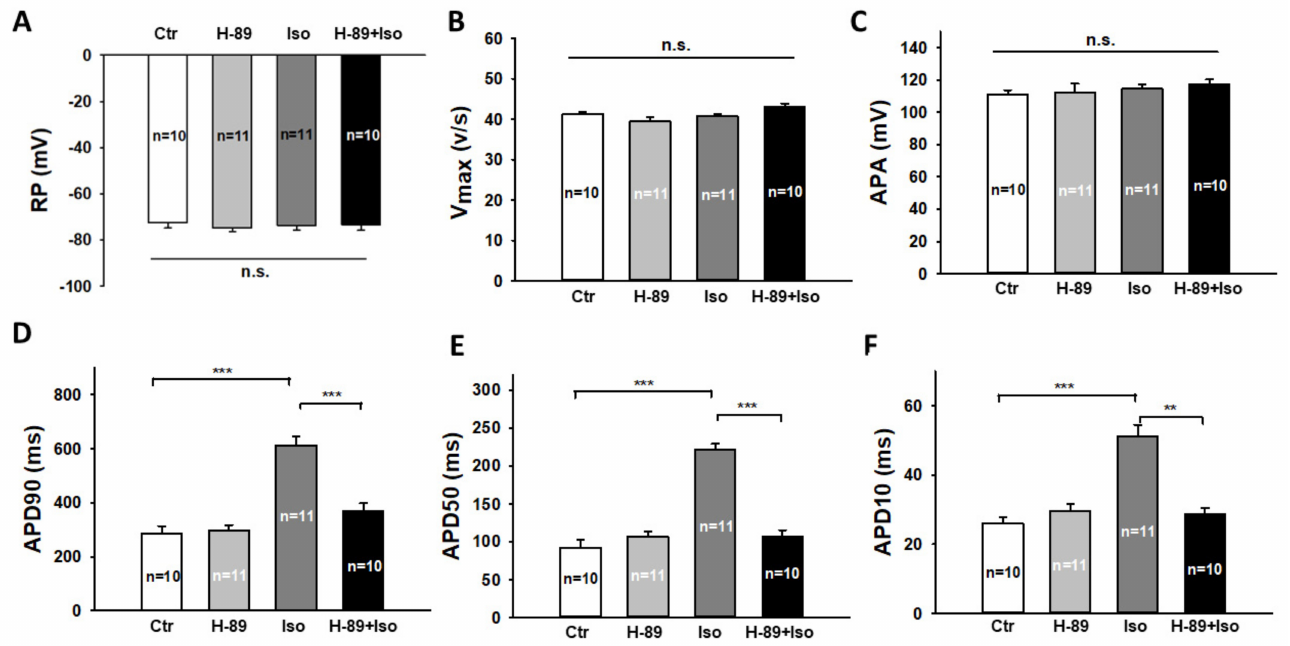
Figure 7. A PKA blocker attenuated the toxic effects of isoprenaline on action potentials in hiPSC- CMs. “Ctr” represents data from hiPSC-CMs treated with vehicle. “H-89” represents data from hiPSC-CMs treated with H-89 (10 µ M). “Iso” represents data from hiPSC-CMs treated with a high concentration of Iso (1 mM). “H-89+Iso” represents data from hiPSC-CMs treated with H-89 plus a high concentration of Iso. Action potentials (AP) were recorded at 1 Hz stimulation. ( A ) Mean values of resting potentials (RP). ( B ) Mean values of maximal depolarization velocity of AP (Vmax). ( C ) Mean values of action potential amplitude (APA). ( D ) Mean values of action potential duration at 90% repolarization (APD90). ( E ) Mean values of action potential duration at 50% repolarization (APD50). ( F ) Mean values of action potential duration at 10% repolarization (APD10). Data are presented as mean ± SEM and analyzed by one-way ANOVA with Holm–Sidak post-test. The cell number of every experimental group is given as “n”. ** p < 0.01, *** p < 0.001. “n.s.” means no